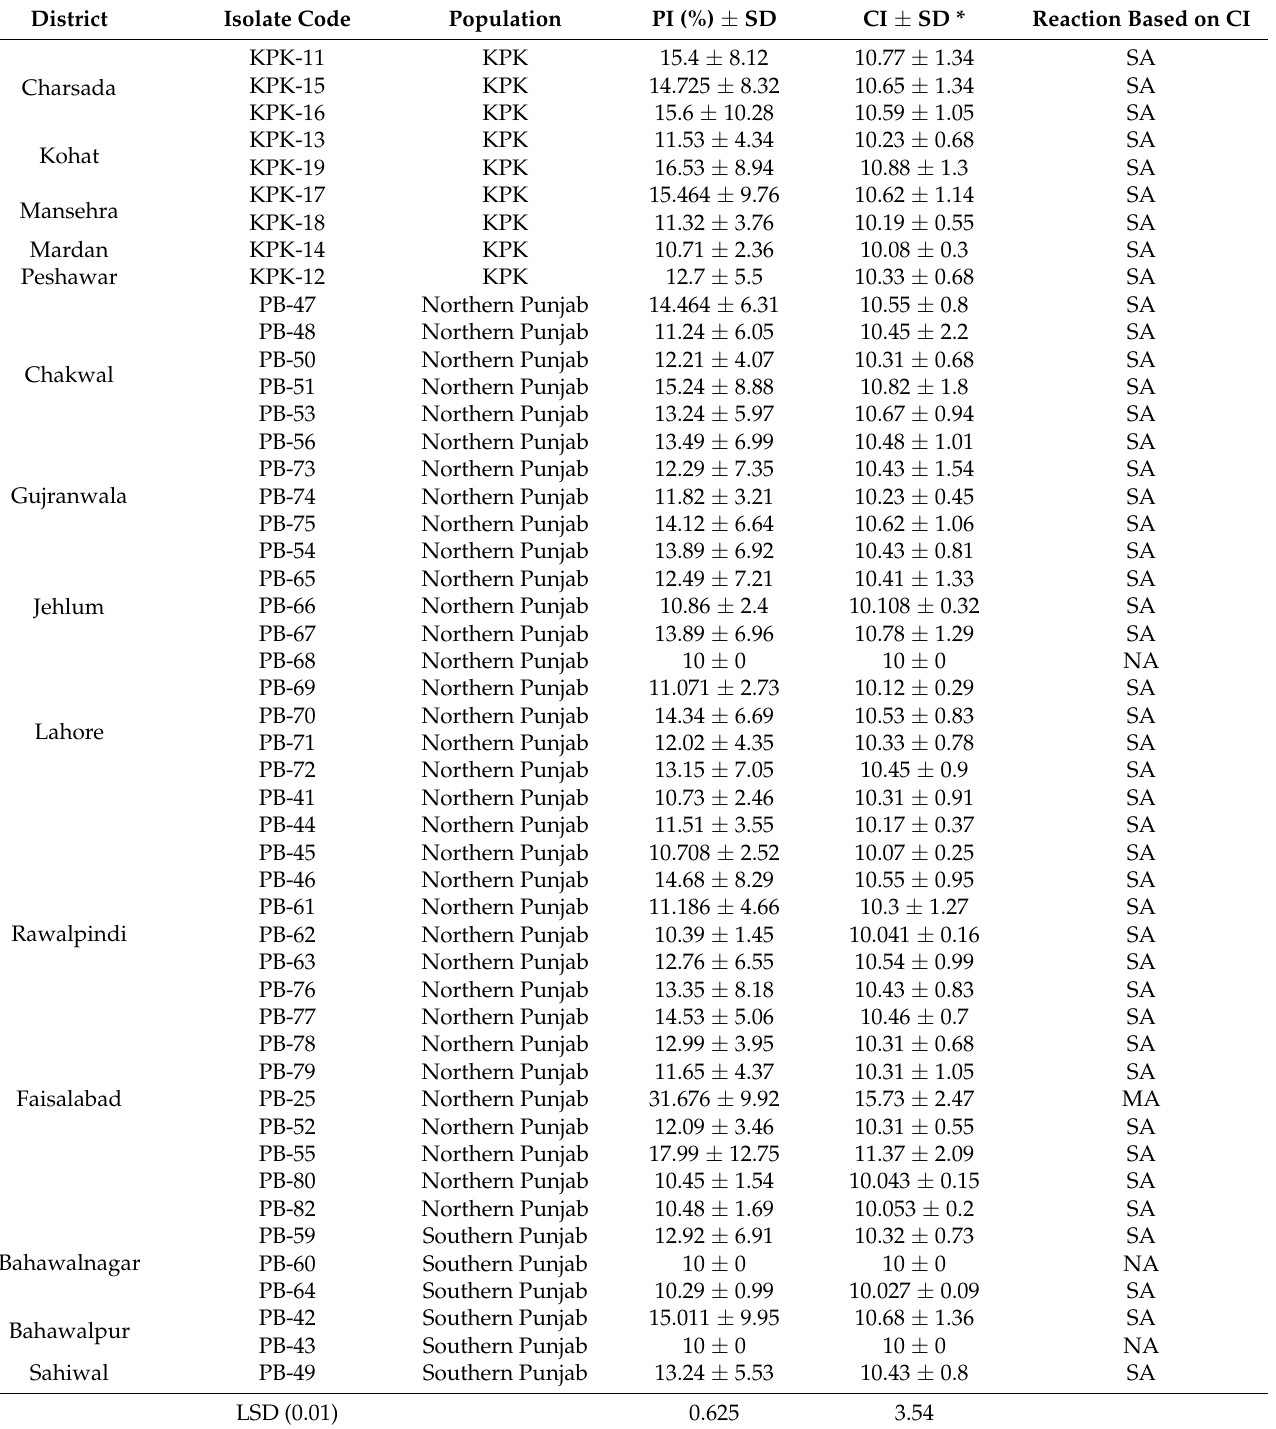
Table 3. The aggressiveness behavior of T. indica on different wheat